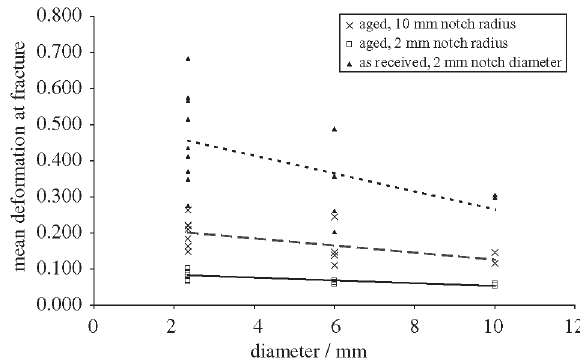
Figure2. Effect of thermal aging and the specimens geometry on the mean deformation at